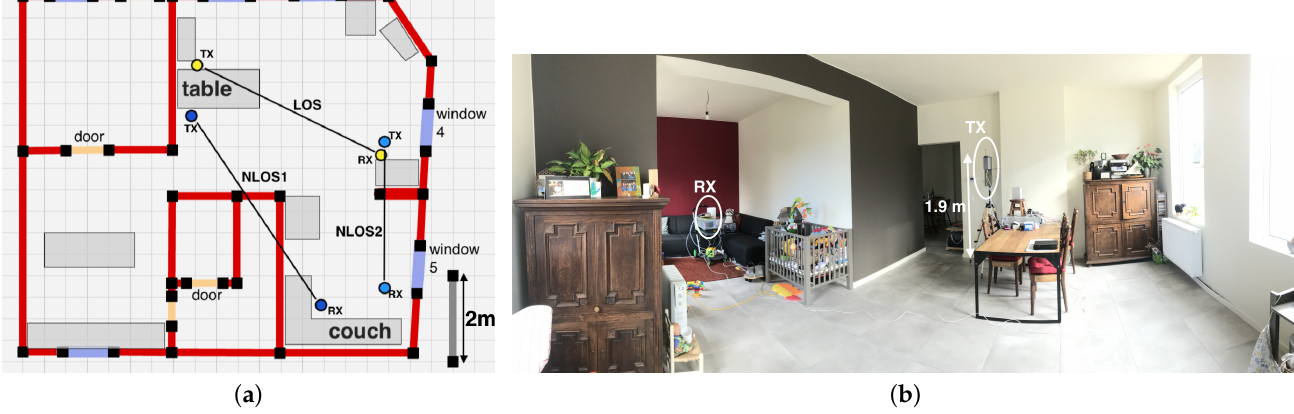
Figure 3. Living room environment. ( a ) Floor plan; ( b ) Picture of non-Line-of-Sight (NLOS) measure- ment setup NLOS2 with obstructed path distance 4.7